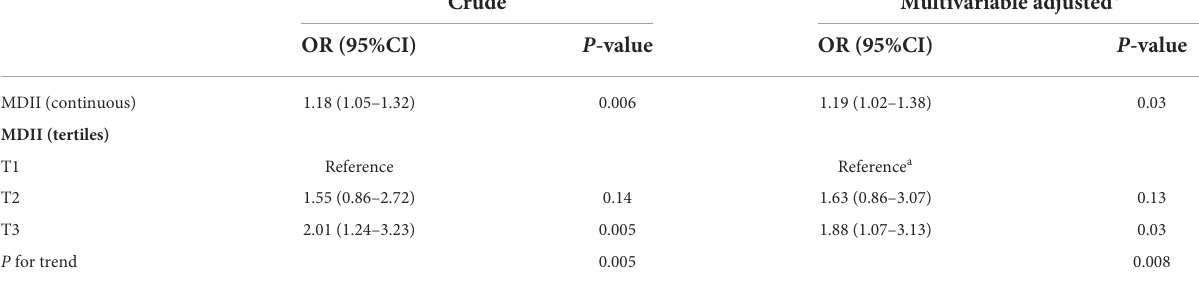
TABLE 5 Association of MDII score and OP risk in postmenopausal female participants.